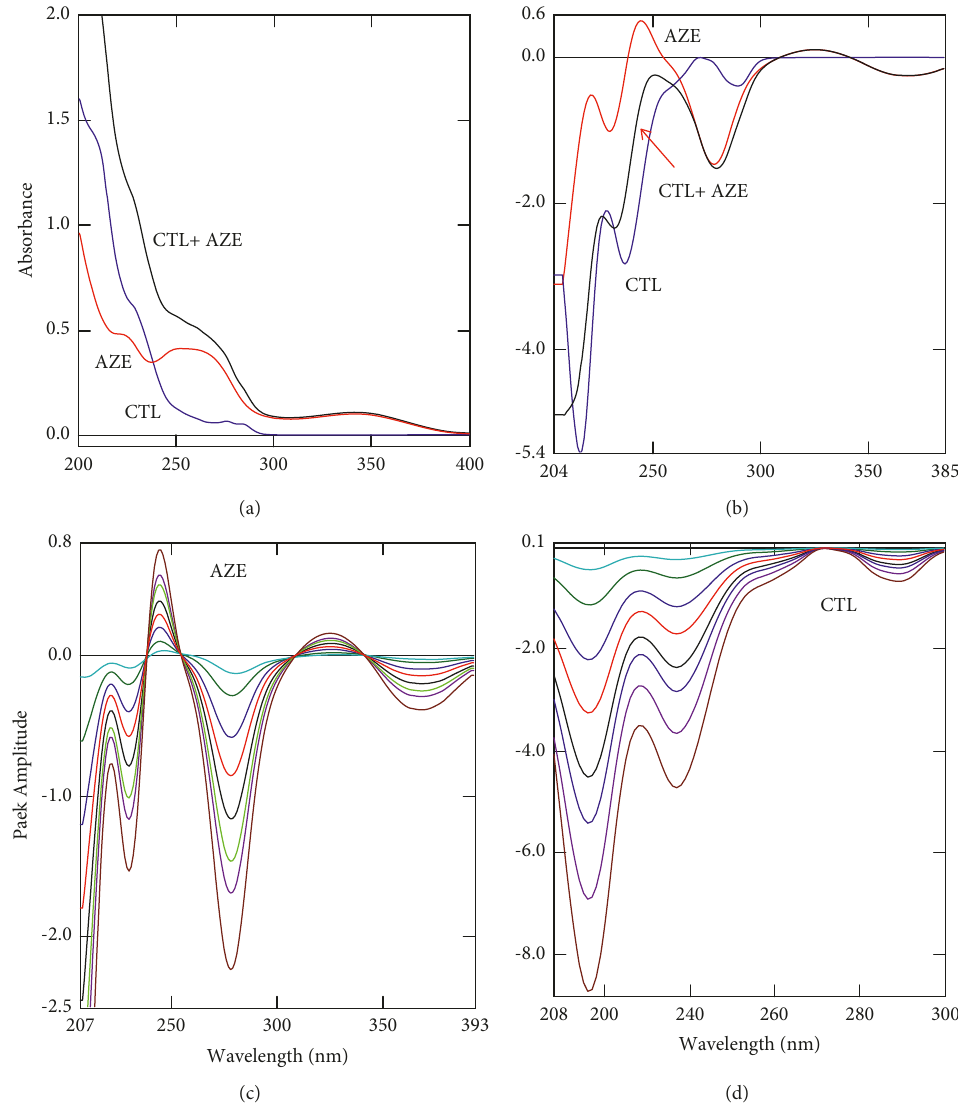
Figure 2: (a) Normal spectra of CTL (blue), AZE (red), and Mixture (black); (b) first derivative spectra of CTL (blue), AZE (red), and mixture (black); (c) first derivative spectra (1–15 μ g/mL) of AZE; (d) first derivative spectra (1–15 μ g/mL) of